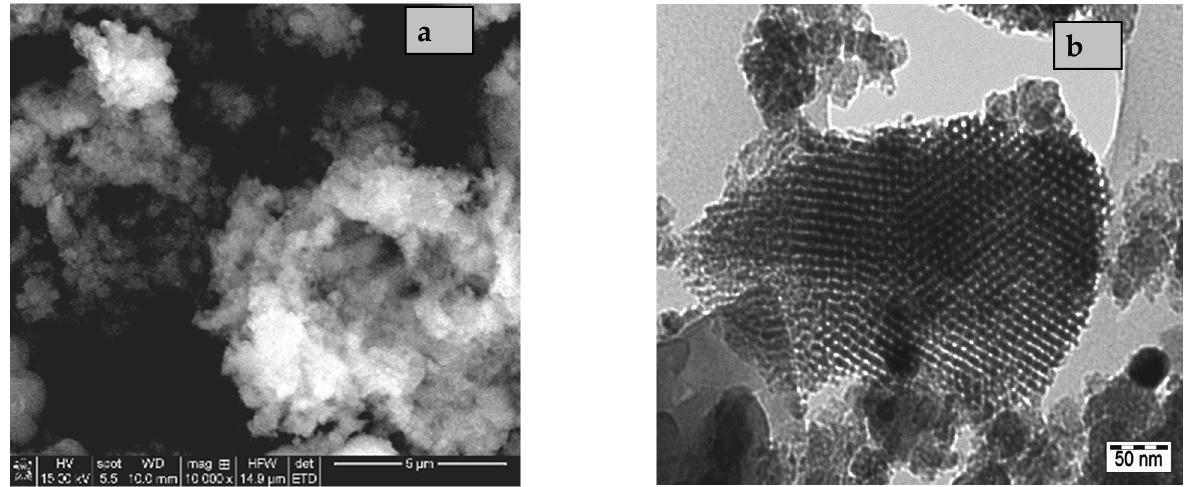
Figure 3. SEM images ( a ) and TEM images ( b ) of the selected KIT-6 sample.